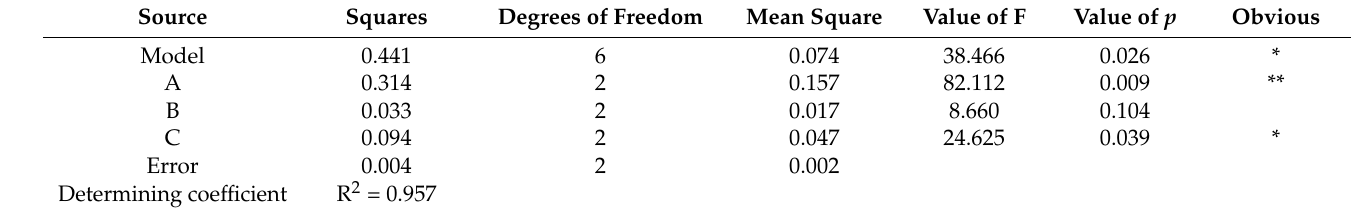
Table 3. Analysis of variance.